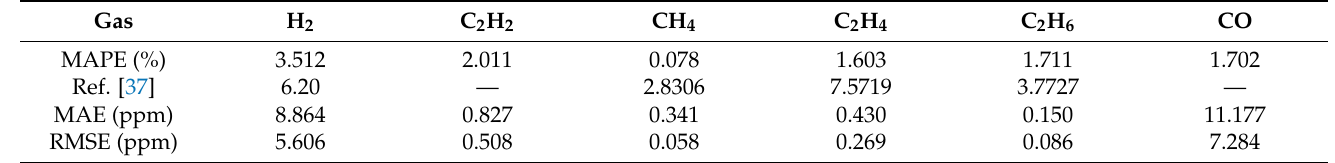
Table 10. Results of the errors for the one-step predictions shown in Figures 4–6.